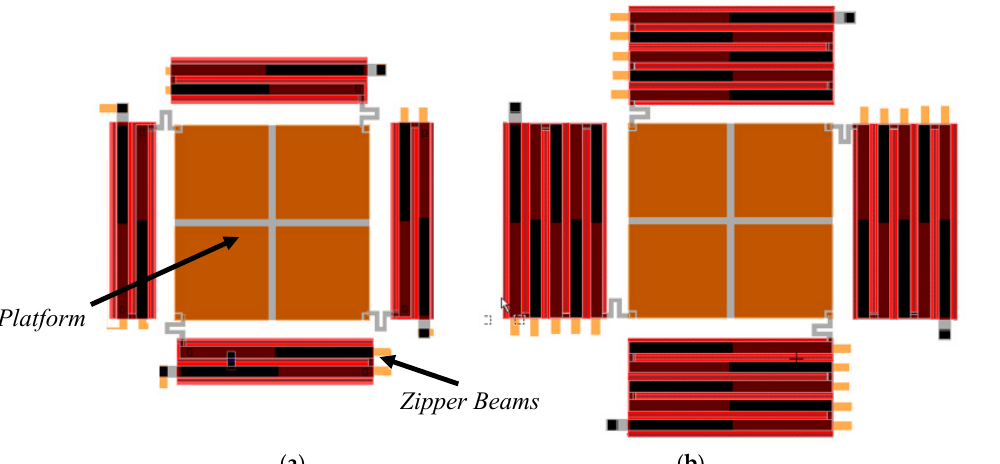
Figure 2. Designs of electrostatically actuated mirror with segmented electrodes underneath the zipper beams for actuating a 500 micron × 500-micron platform. ( a ) is a two-segment and ( b ) is a five- segment zipper beam. Image was created using L-Edit ® software under license to Air Force Institute of Technology.